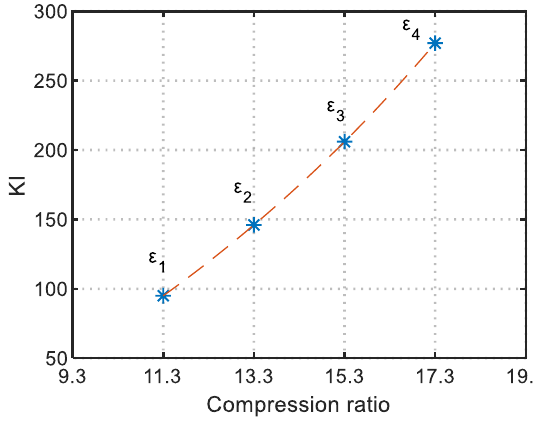
Figure 17. Knock intensity under different compression ratio.